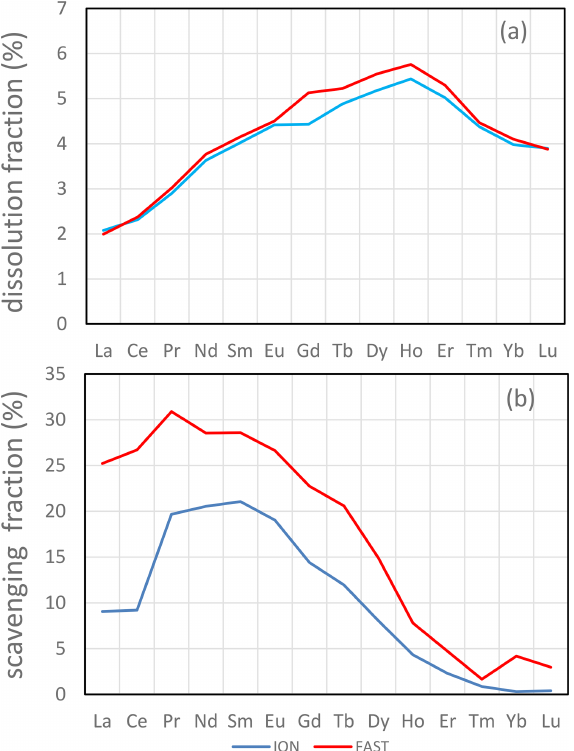
Figure 5. (a) Average maximum dissolution ( f dissol_conc , given in percent) and (b) scavenging fractions ( f scav , given in percent) for REEs. For comparison purposes, scavenging was calculated with data at t = 72h for both ION and